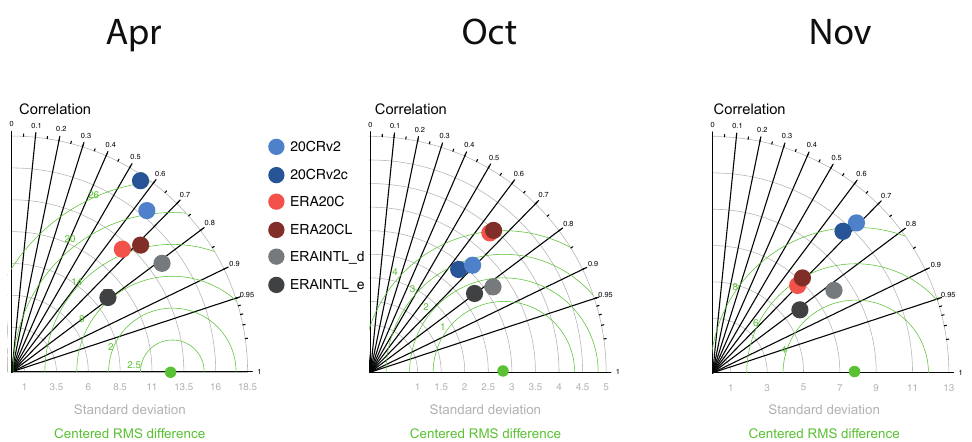
Figure 5. Taylor diagrams showing the median of the 13 station locations using daily data for the period 1981-2010. The x axis and y axis indicate the standard deviation, the radians indicate correlation values and the green circles indicate the centered RMSE. The green dot shows the observed variability. For more details concerning the datasets statistics, see Supplement Figs. S3–S6. ERA-20C is labeled as ERA20C, ERA-20C land is labeled as ERA20CL, ERA-Interim land-d is labeled as ERAINTL_d, and ERA-Interim land-e is labeled as